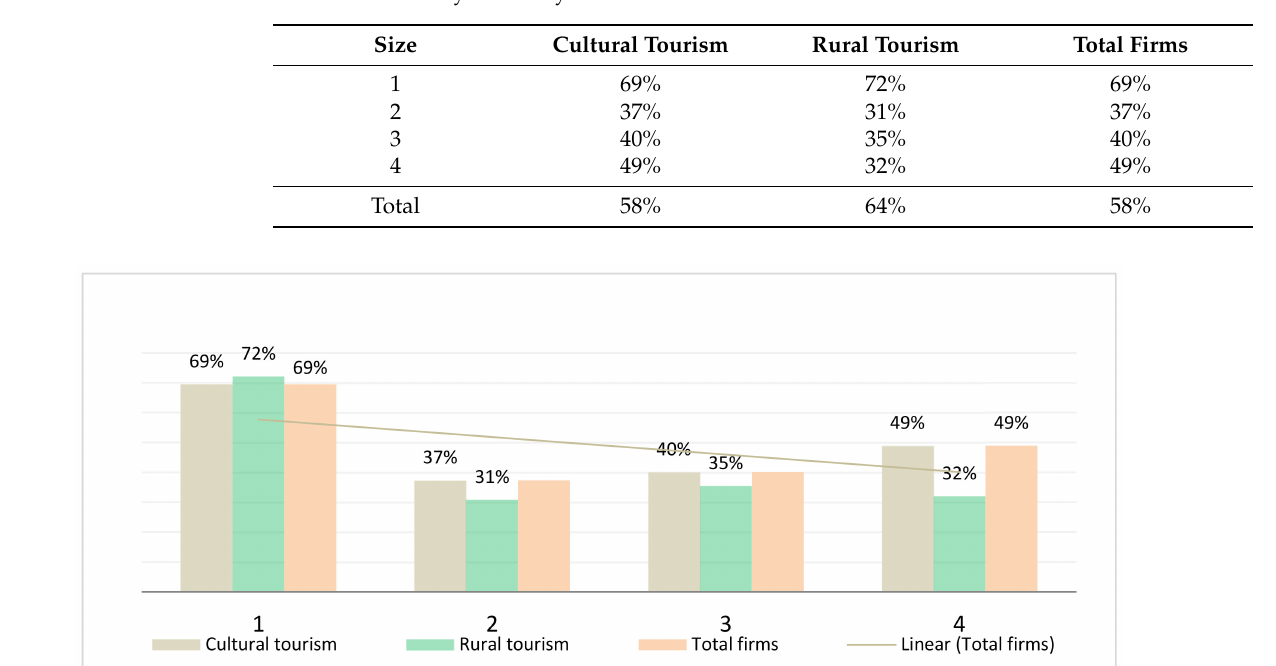
Table 10. Efficiency results by size.